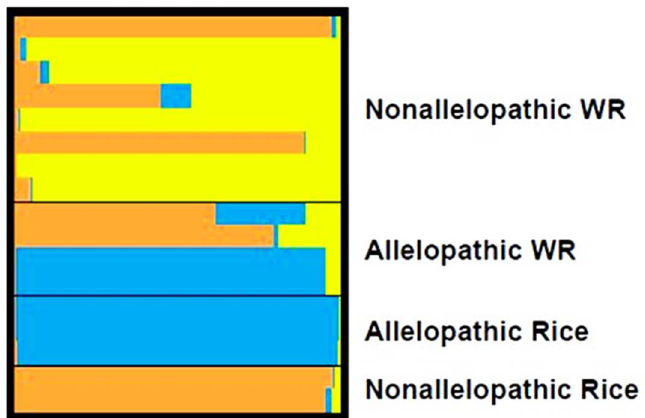
Figure 5. Population structure of accessions based on allelopathic potential.